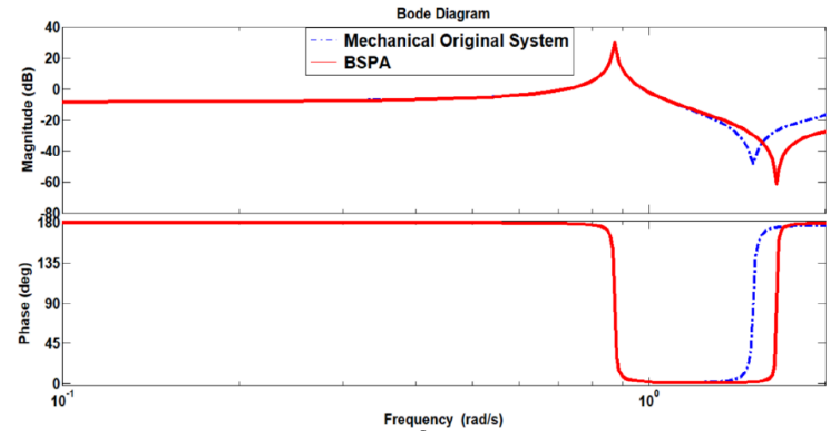
Figure 10. Frequency response of the ROM with mechanical